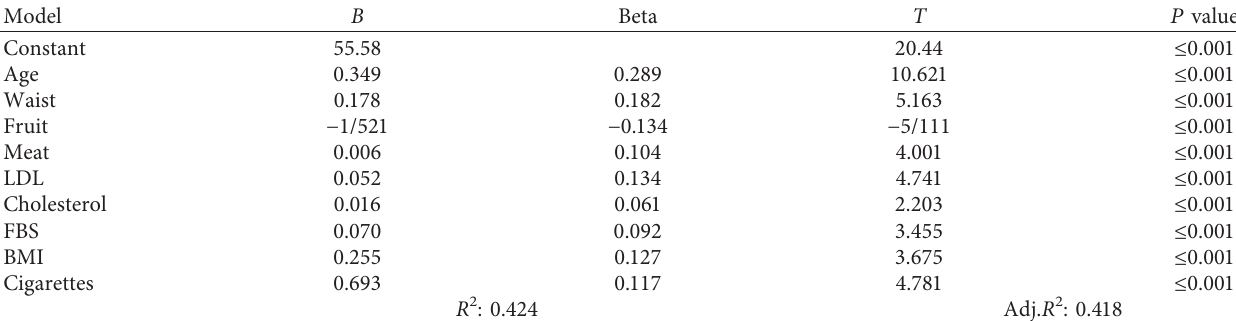
Table 5: The multiple linear regression model predicting SBP changes based on